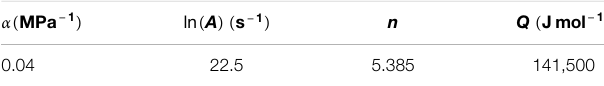
TABLE 1 | Material constants of the Sellars – Tegart constitutive equation for